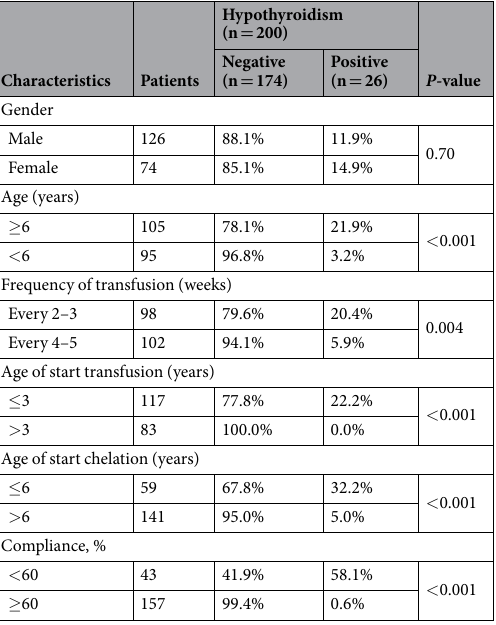
Table 6. Association between hypothyroidism and each of the demographic, frequency of transfusion, age of start transfusion, Age of start chelation,